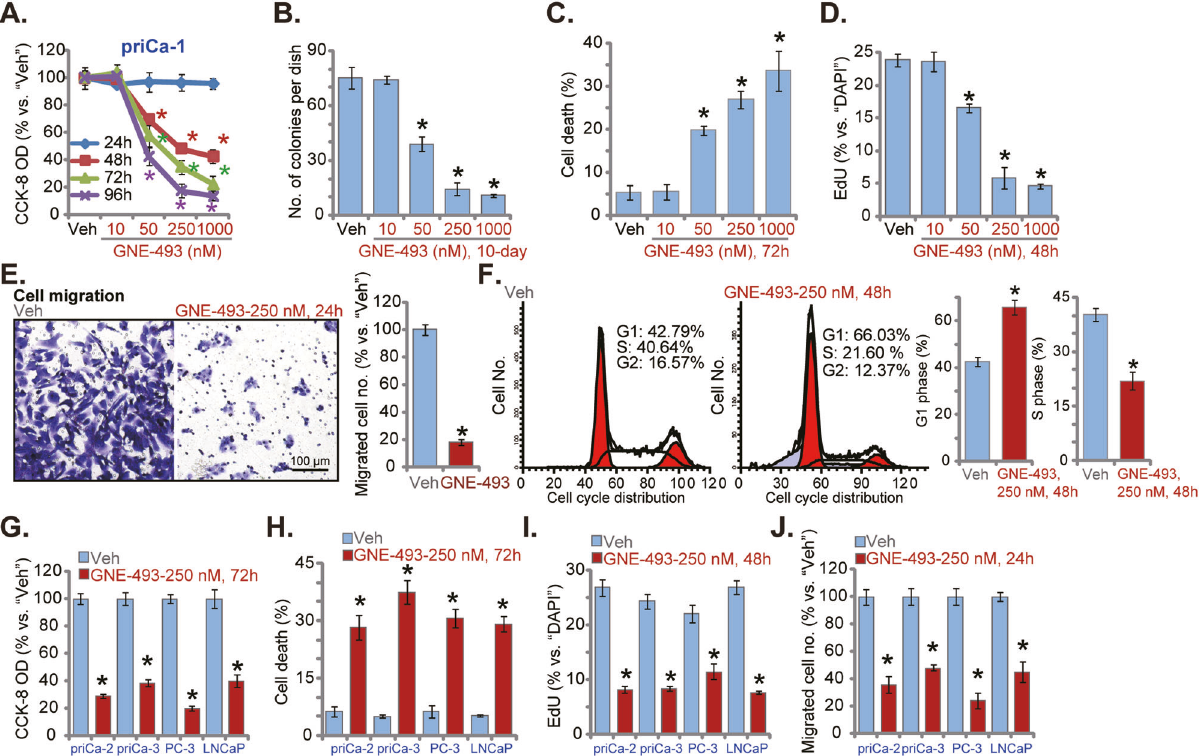
Fig. 1 GNE-493 exerts tumor-suppressive activity in cultured prostate cancer cells. The patient-derived primary prostate cancer cells ( “ priCa-1/-2/-3 ” , that were derived from three patients) or established cell lines (PC-3 or LNCaP) were cultivated in complete medium and stimulated with the applied concentrations of GNE-493 (10 – 1000 nM) or the vehicle control (0.25% DMSO, “ Veh ” ); cells were further cultivated for a designated time, cell viability (by measuring CCK-8 OD, A and G ), the number of cell colonies ( B ), cell death (by recording the Trypan blue percentage, C and H ), and cell proliferation (by recording the EdU-positively stained nuclei percentage, D and I ) as well as the in vitro cell migration ( “ Transwell ” assays, E and J ) and distribution of cell cycles (PI-FACS assays, F ) were tested. * P < 0.05 versus “ Veh ” group. Scale bar = 100 μ m ( E